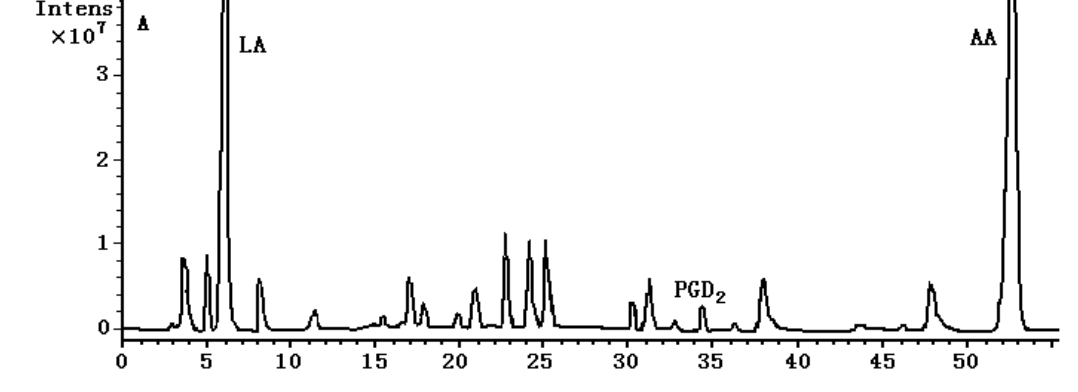
and AA respectively in negative ion 2 4